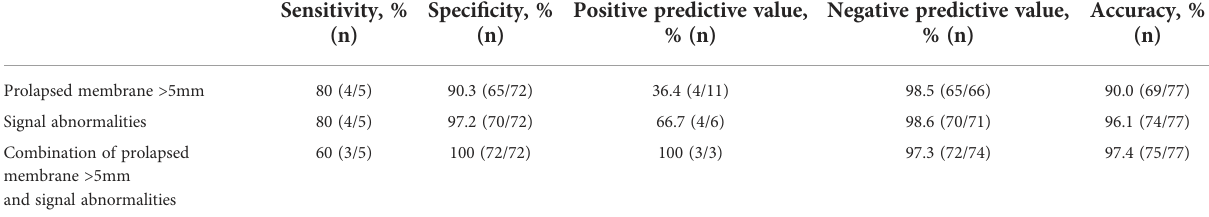
TABLE 4 Ability of MRI-detected FM defects to predict